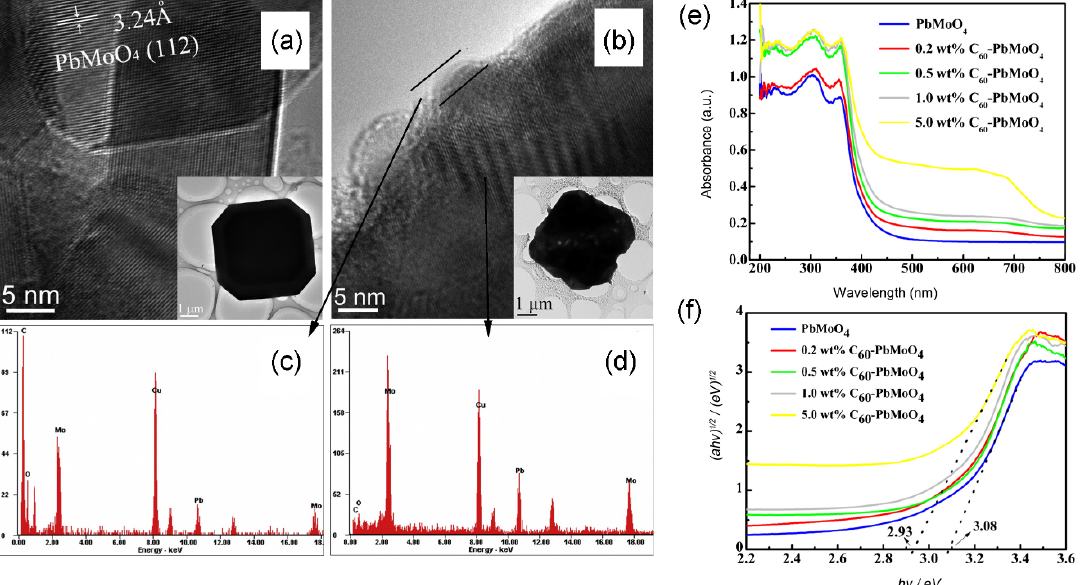
Figure 8. HRTEM images of PbMoO 4 ( a ) and C 60 -PbMoO 4 ( b ). EDS spectrum measured from the edge ( c ) and the center of C 60 –PbMoO 4 composite ( d ). ( e ) DRS of the C 60 –PbMoO 4 samples and pure PbMoO 4 composite. ( f ) Plot of (αhν) 1/2 versus photon energy (hν) based on the DRS. Reproduced with permission from Reference [50]. Copyright 2013, Elsevier.